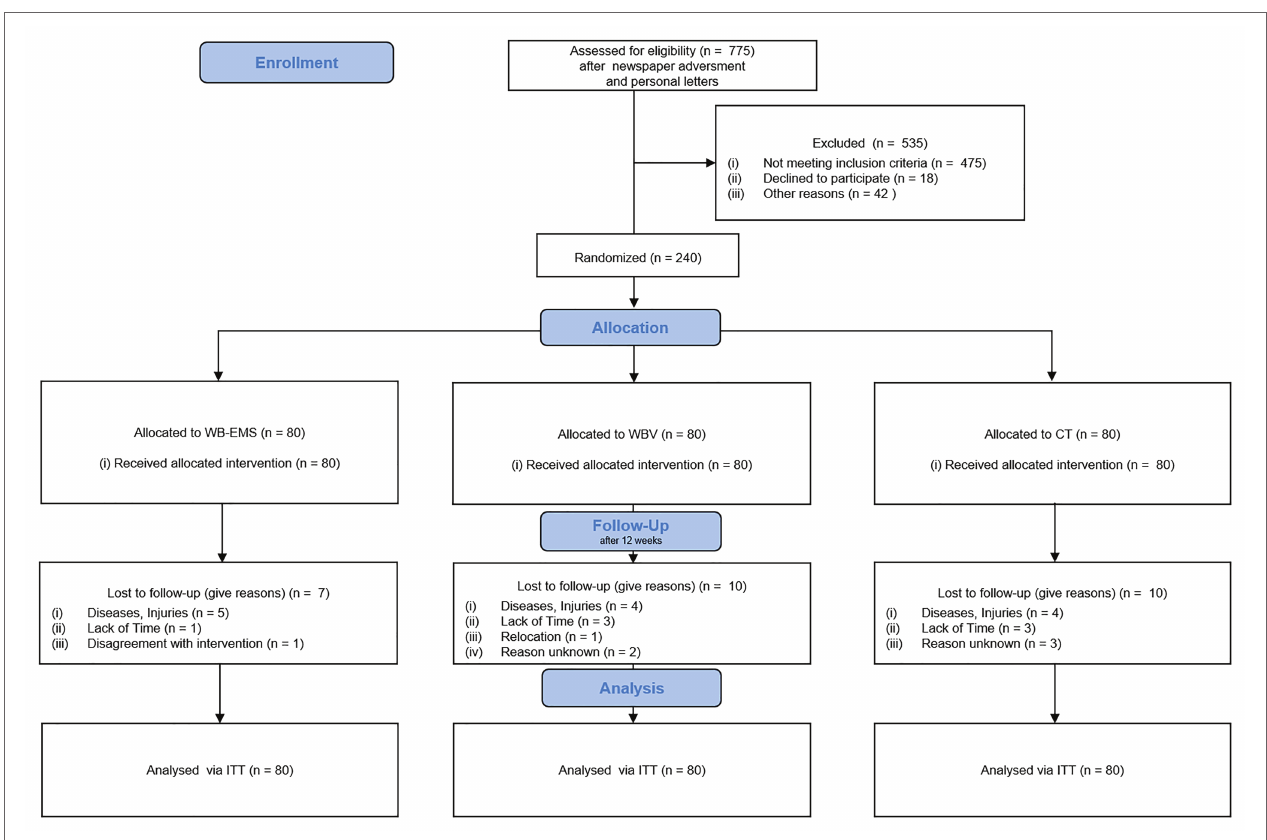
FIGURE 1 | CONSORT flow diagram of the study intervention.